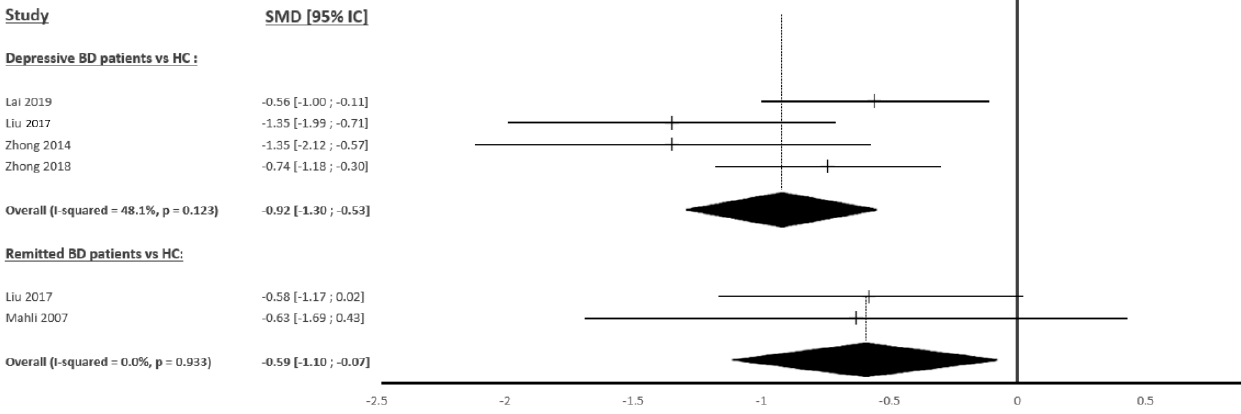
Figure 3. Studies Standardized Mean Differences (SMDs) of N-acetylaspartate differences between bipolar patients and controls in the left white matter prefrontal cortex [44,46,47,61,62].